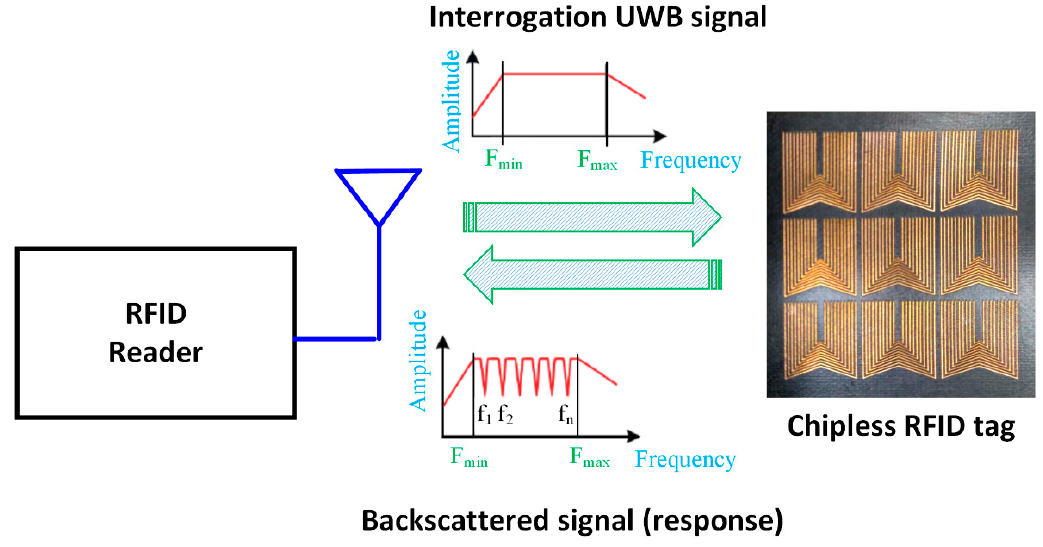
Figure 1. Monostatic setup for the proposed chipless radio-frequency identification (RFID) tag.